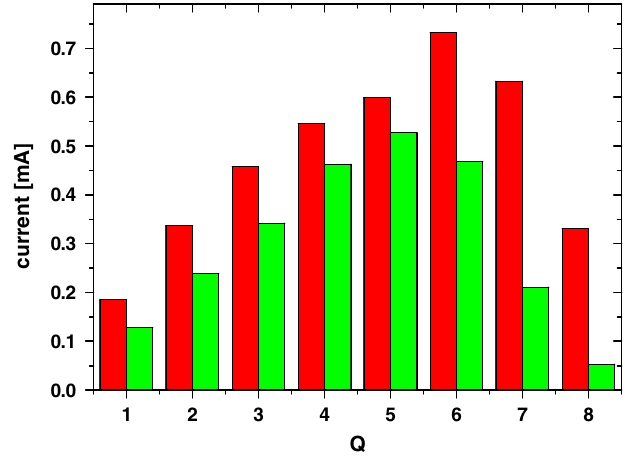
FIG. 13. (Color) Charge-state distributions of the extracted neon ions for the reference conditions (green columns) and for the doubled plasma chamber length (red